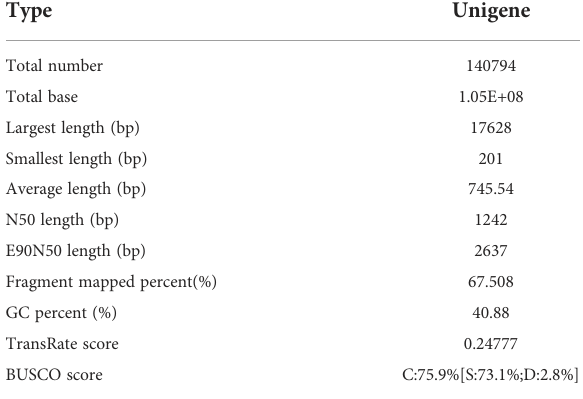
TABLE 2 Transcriptome de novo assembly